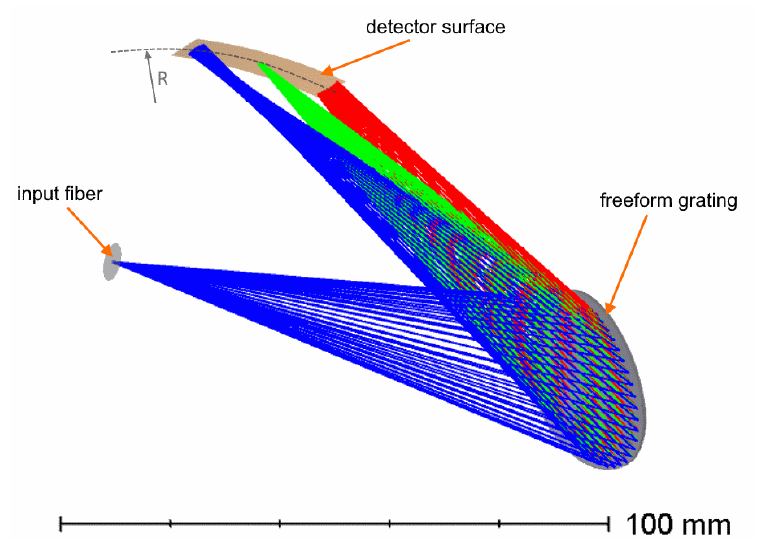
Figure 5. Optical design of the high-dispersion spectrograph with a freeform grating (Design